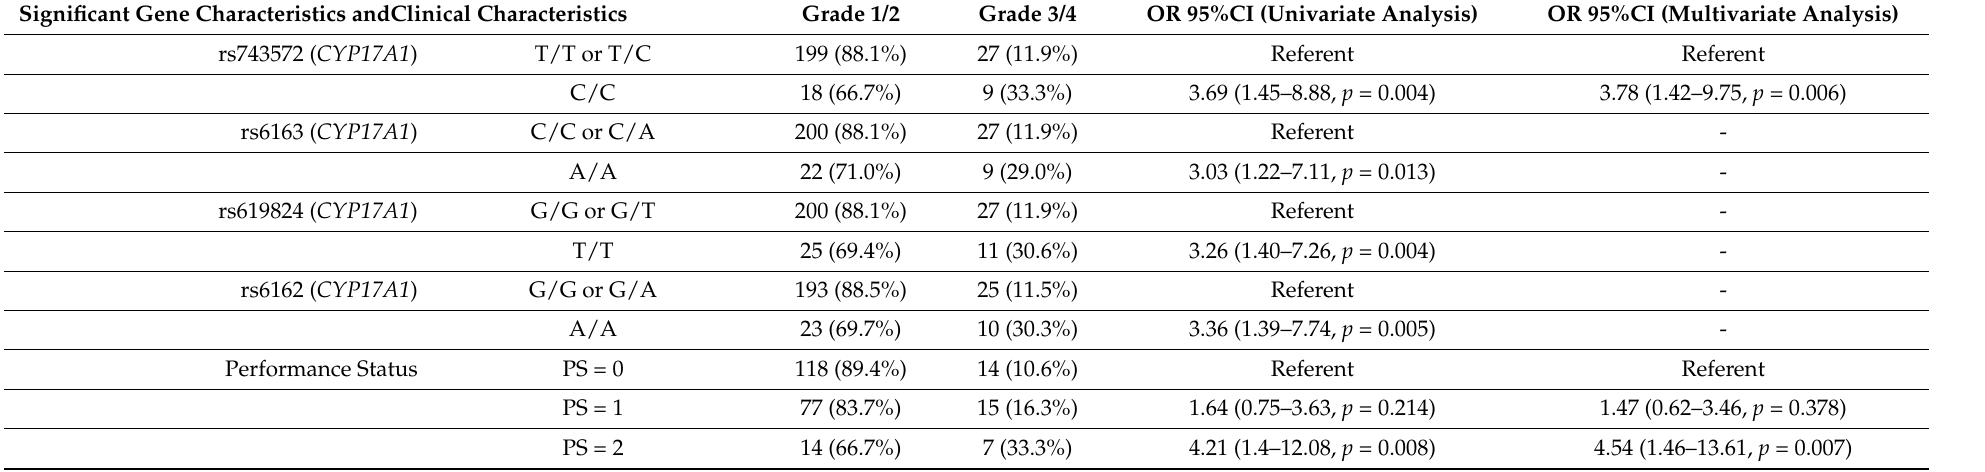
Table keys: Baseline PSA value at 10 ng/mL represents the first quartile, and the value of 32 ng/mL is the median value. The considered SNPs were those initially selected from univariate